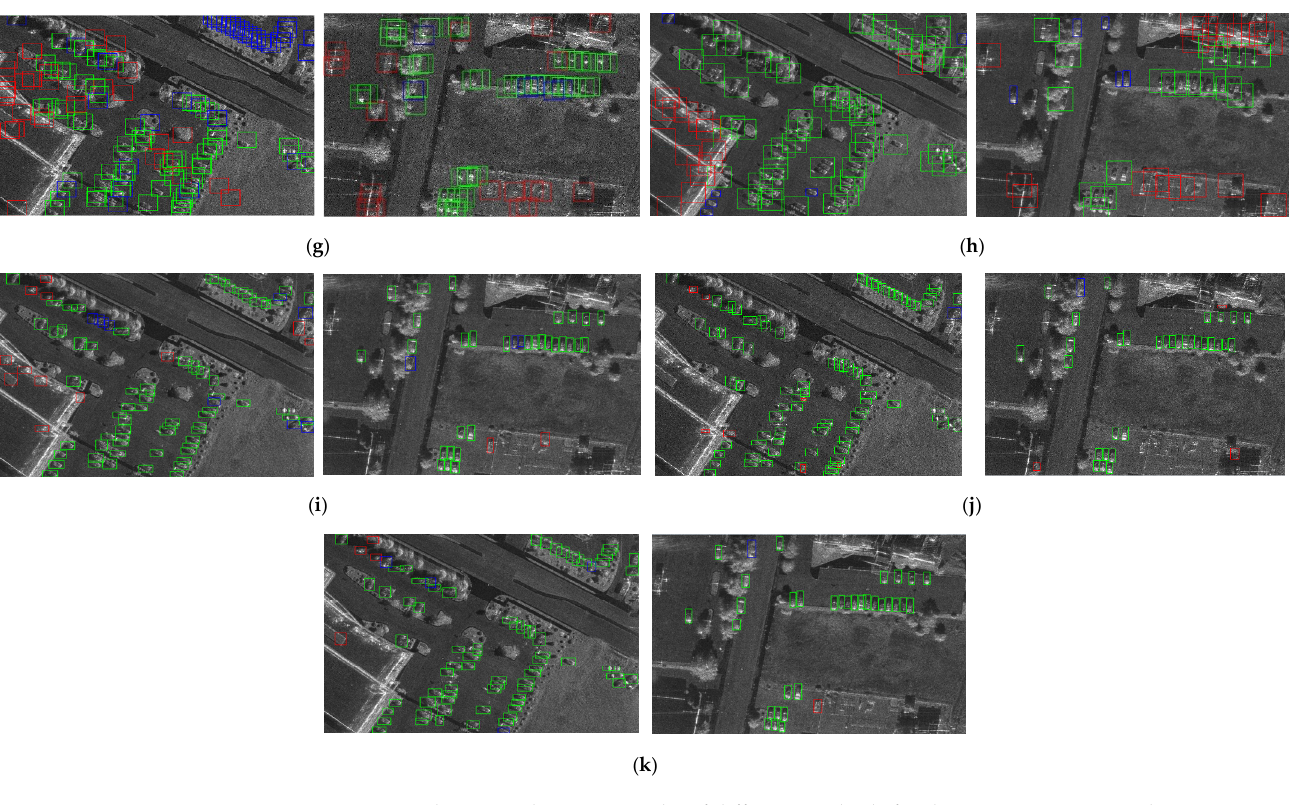
Figure 11. The target detection results of different methods for the two test images in the FARADSAR dataset, where the green, red, and blue rectangles indicate the correctly detected cars, the false cars, and the missing cars, respectively. ( a ) Gaussian-CFAR. ( b ) DAF. ( c ) HTCN. ( d ) Faster R-CNN. ( e ) DAPN. ( f ) YOLOv5. ( g ) Rosenberg’s method. ( h ) Zhang’s method. ( i ) STAC. ( j ) Soft Teacher. ( k ) Proposed FDDA. Table 5. The target detection results of different methods on the FARADSAR